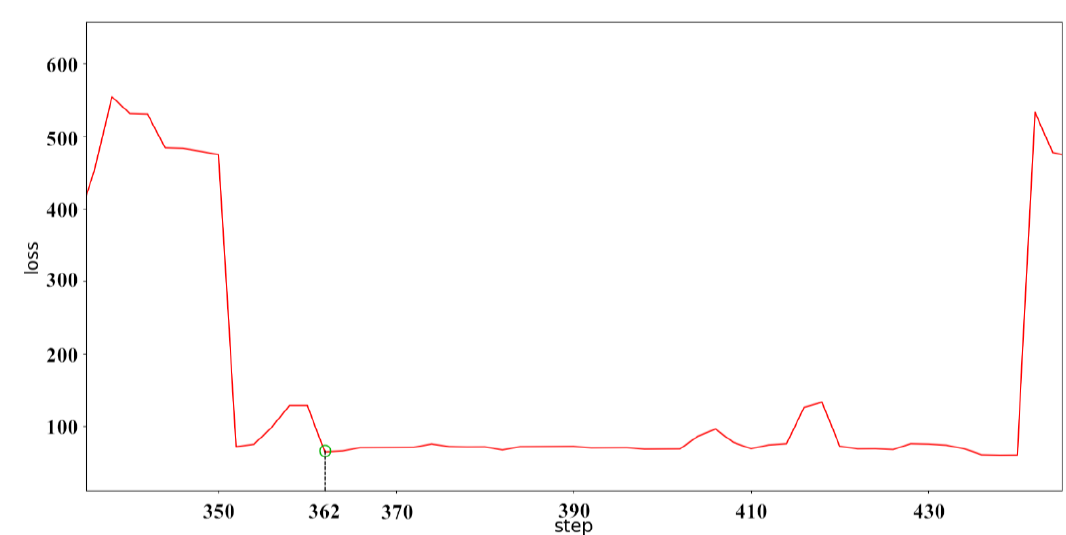
Figure 15. Schematic of ship behavior prediction.